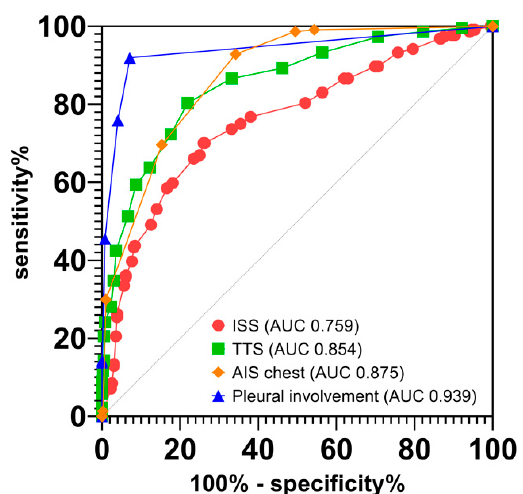
Figure 2. Receiver operating characteristic curve analysis of trauma score associations for chest tube placement. ISS, injury severity score; AUC, area under the receiver operating characteristic curve; TTS, thoracic trauma severity score; AIS, abbreviated injury severity